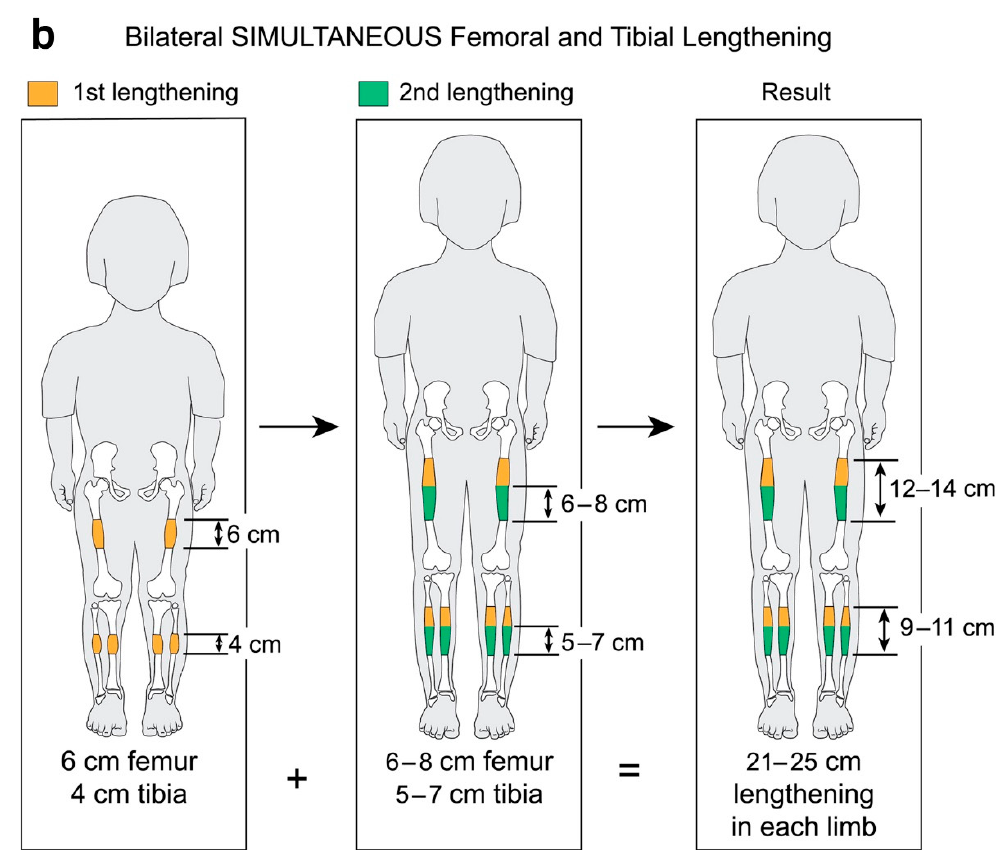
Figure 1. ( a ) Sequential extensive lengthening. ( b ) Moderate simultaneous bilateral femoral tibial lengthening (SBFTL). Both the extensive and the moderate strategies result in the same 20 cm of total lengthening (used with permission).